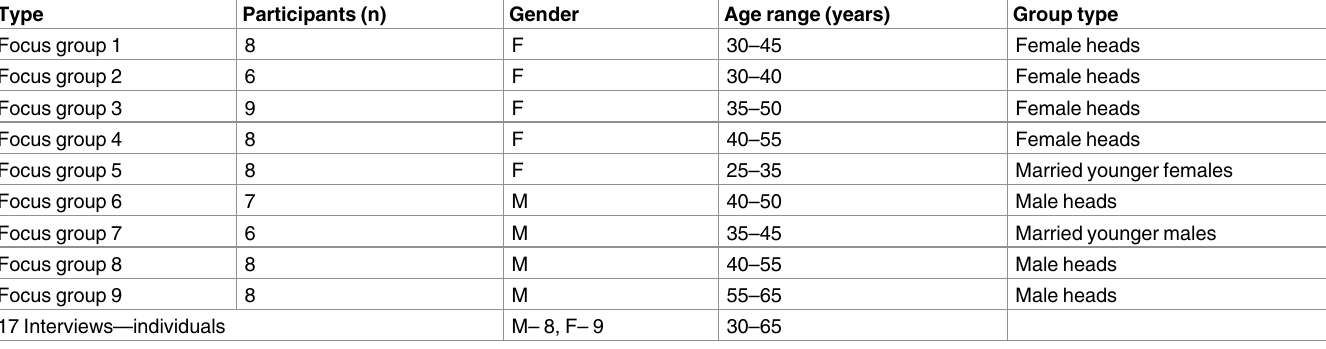
Table 1. Characteristics of participants in focus groups and individual